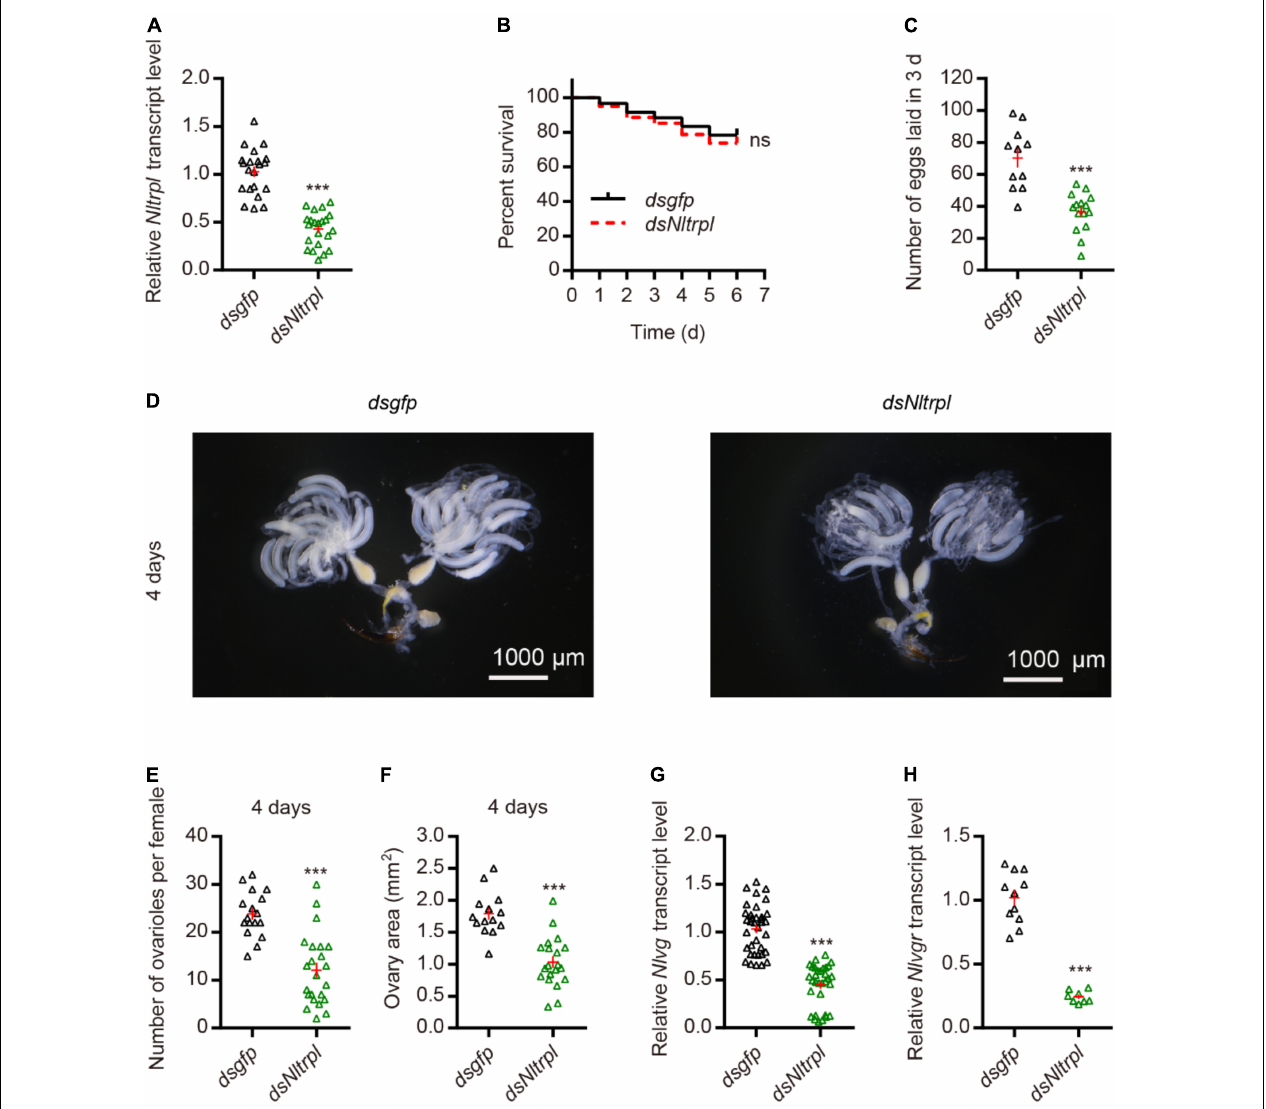
FIGURE 3 | Knockdown of Nltrpl in the brown planthopper (BPH) impaired egg-laying behavior. (A) Downregulation of Nltrpl in BPH using dsNltrpl reduced mRNA expression levels compared to BPH injected with dsgfp . (B) Survival rate of BPH injected with dsgfp ( n = 60) and dsNltrpl ( n = 60). Survival analyses with log-rank test: χ 2 = 0.3669, not significant (ns). (C) Number of eggs laid during the 3 days after dsgfp or dsNltrpl injection. Underdeveloped ovaries (D) and detained eggs per ovary (E) per female 4 days after injection of dsgfp or dsNltrpl . (F) Ovary area in per female 4 days after injected with dsgfp or dsNltrpl . mRNA expression level